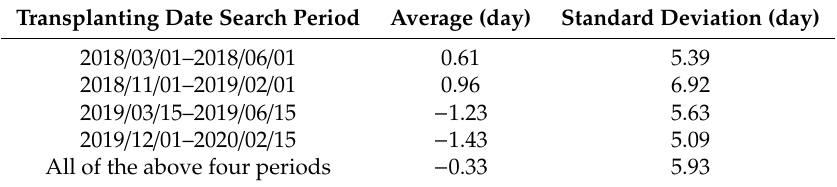
Table 5. Average and standard deviation of the transplanting date estimation errors. Dates are in YYYY / MM / DD